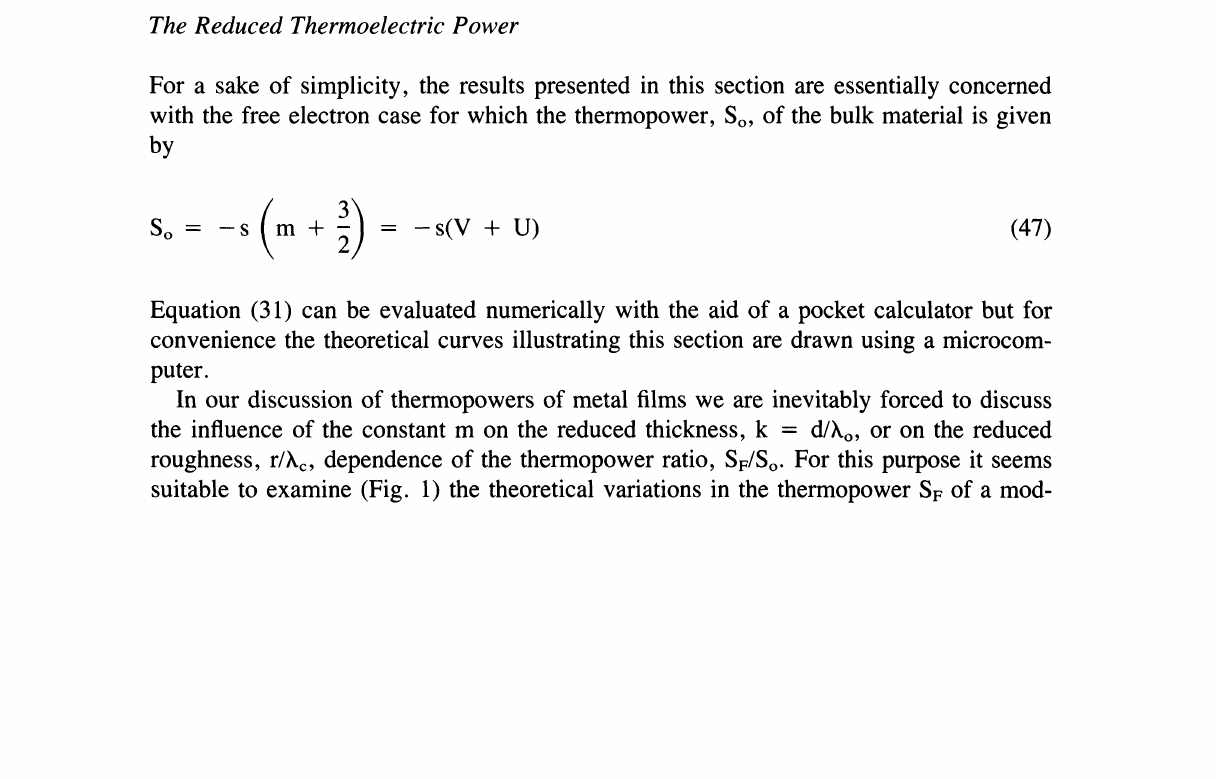
FIGURE Plots of Sf against k for r/hc 0.06, W 5 eV and for different values of m. Curves a, b, c, d, e, f are for rn -3, -2, -1, 0, 0.5 and 1.5